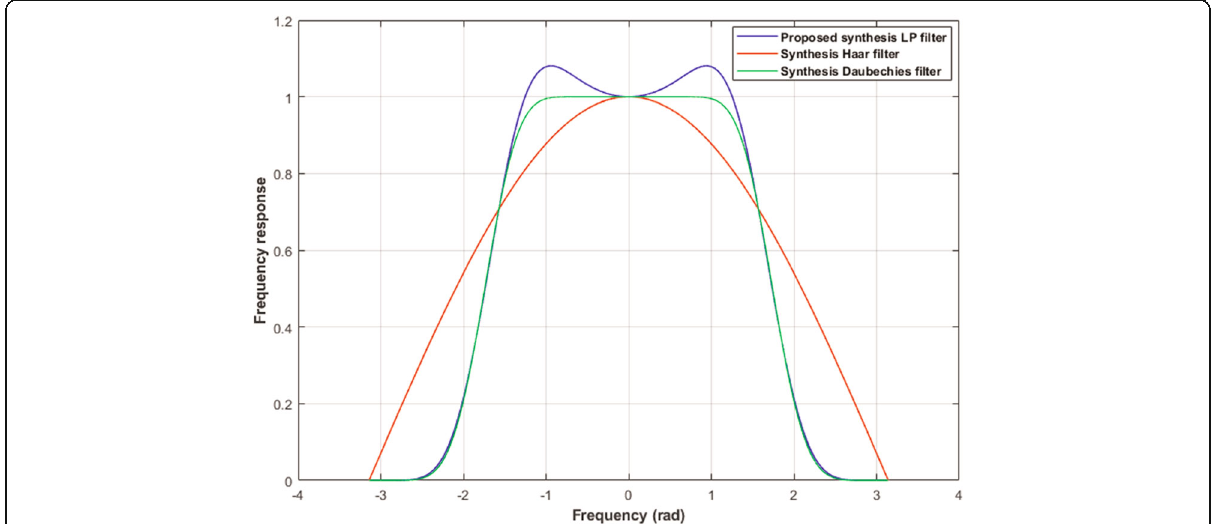
Fig. 8 Frequency response of synthesis low-pass filters for different mother wavelet